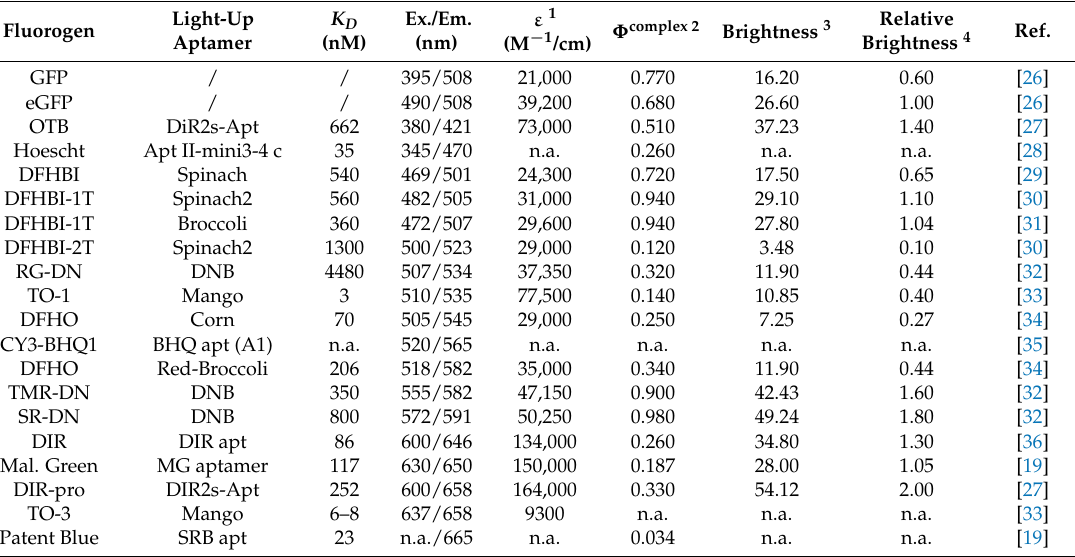
Table 1. Main RNA-based fluorogenic modules and their